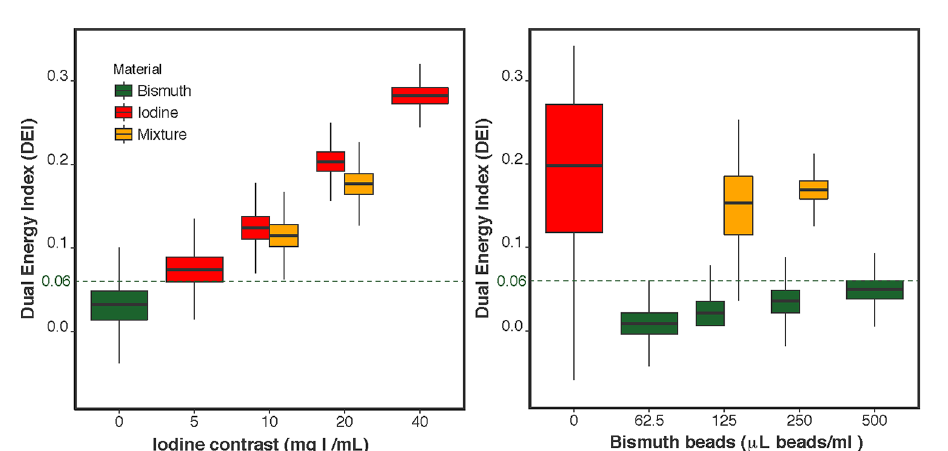
Figure 7. Boxplot of the dual energy index (DEI) calculated per voxel averaged per iodine concentration (left) or bismuth beads (right). The green line represents the DEI threshold of 0.06 which optimally classified